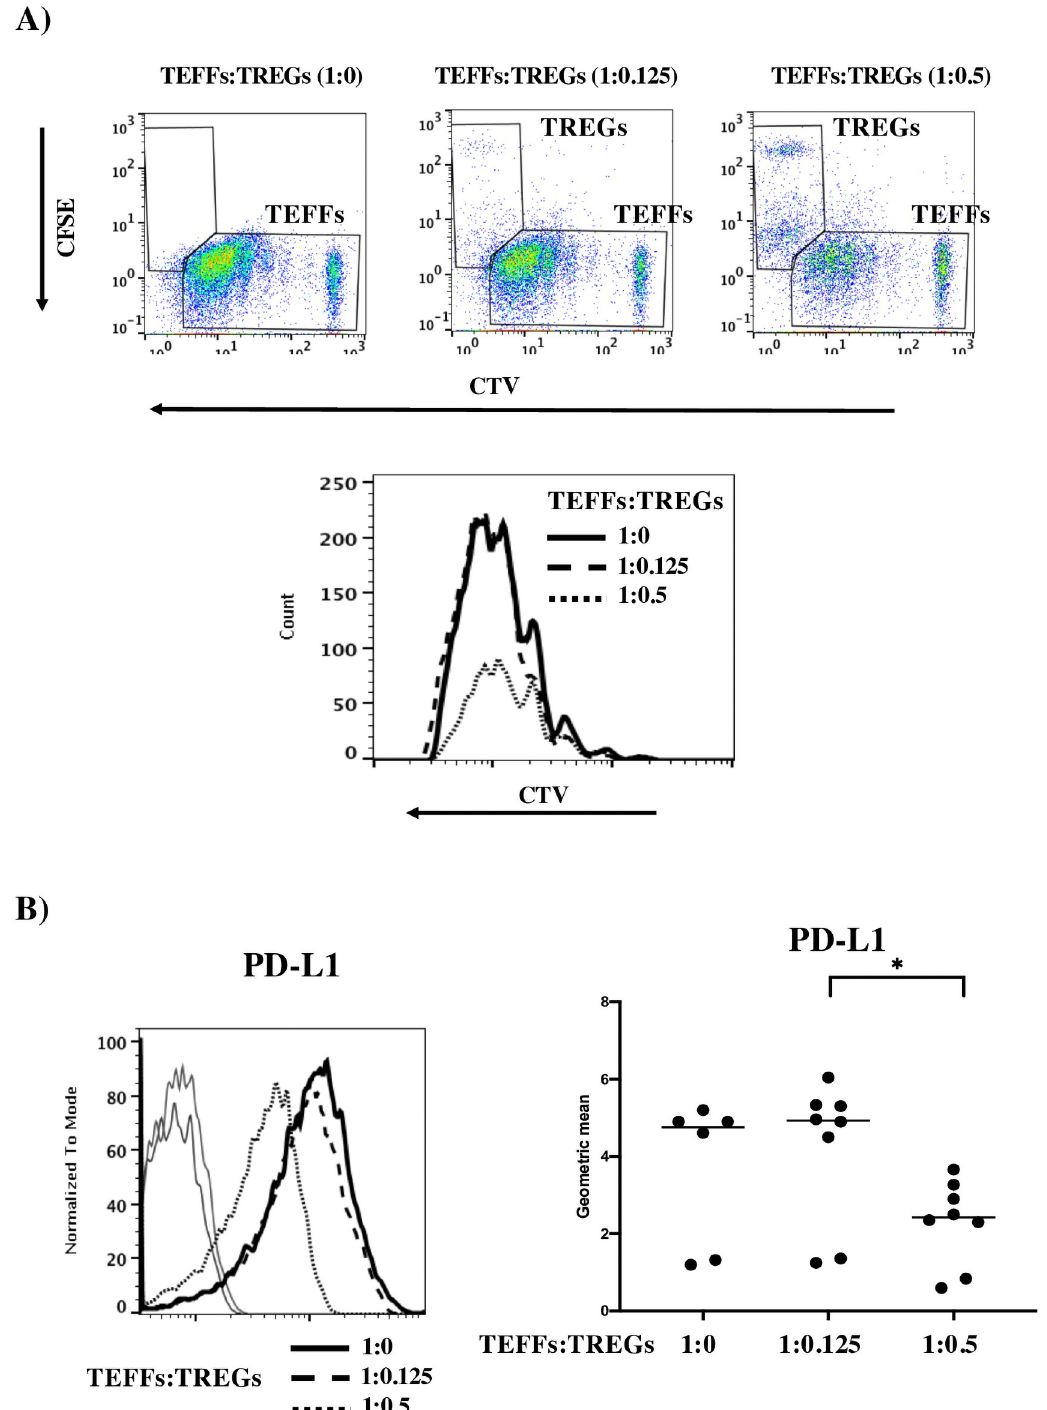
Fig 4. PD-L1 expression on activated TEFFs is dependent on the TEFF:TREG ratio. A) Representative flow cytometry dot plots for the proliferation of CTV-stained TEFFs on D5 of co-culture, with different TEFF: CFSE-stained TREG ratios (1:0 in the left panel, 1:0.125 on the middle panel, and 1:0.5 on the right panel). Lower panel: Representative overlay histograms for the proliferation of CTV-stained TEFFs with different TEFF:TREG ratios: 1:0 (solid black lines), 1:0.125 (dashed black lines), or 1:0.5 (dotted lines). B) Left panel: a representative overlay histogram of PD-L1 expression on activated, CTV-stained TEFFs with a TEFF:TREG ratio of 1:0 (solid black line), 1:0.125 (dashed line) or 1:0.5 (dotted line). Right panel: a graph of PD-L1’s geometric